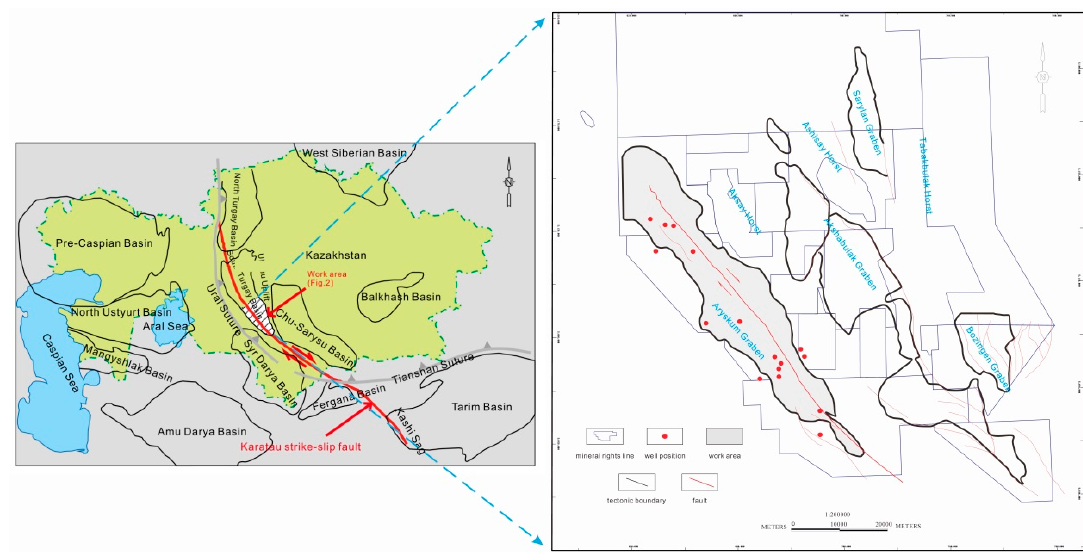
Figure 1. Location of work area and distribution of coring wells.